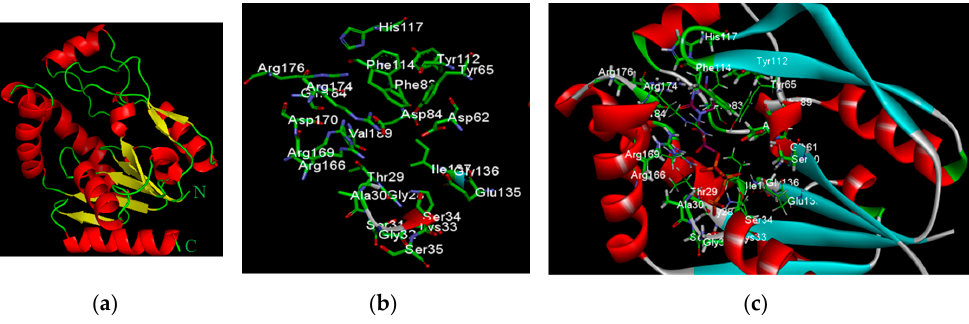
Figure 2. In silico redocking of UCK2 protein in complex with inhibitor CTP. ( a ) Complete x-ray structure of UCK2 receptor protein shown as a cartoon; ( b ) Amino acid residues in the active site of UCK2; ( c ) Interactions of CTP with UCK2 as identified by in silico docking analysis. CTP shown in ball-and-stick model with purple indicating carbon atoms, white for hydrogen, blue for nitrogen, red for oxygen, and phosphorus in orange.